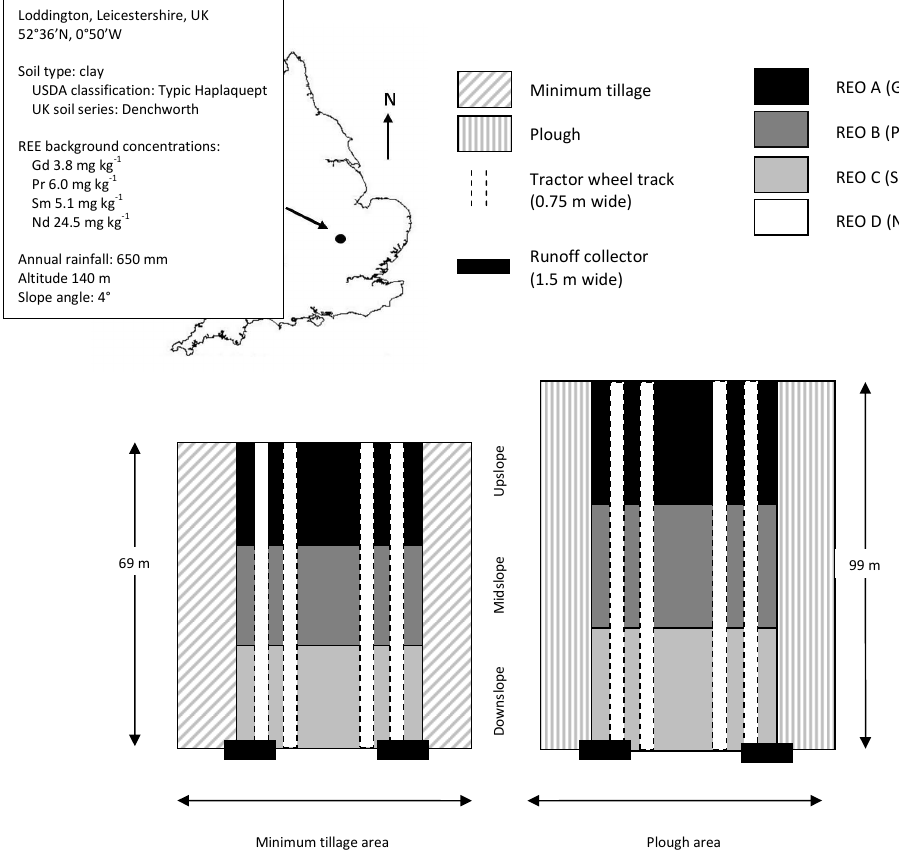
Fig. 1. Location of rare earth oxide (REO) tracer study site, background information and experimental design (not to scale).